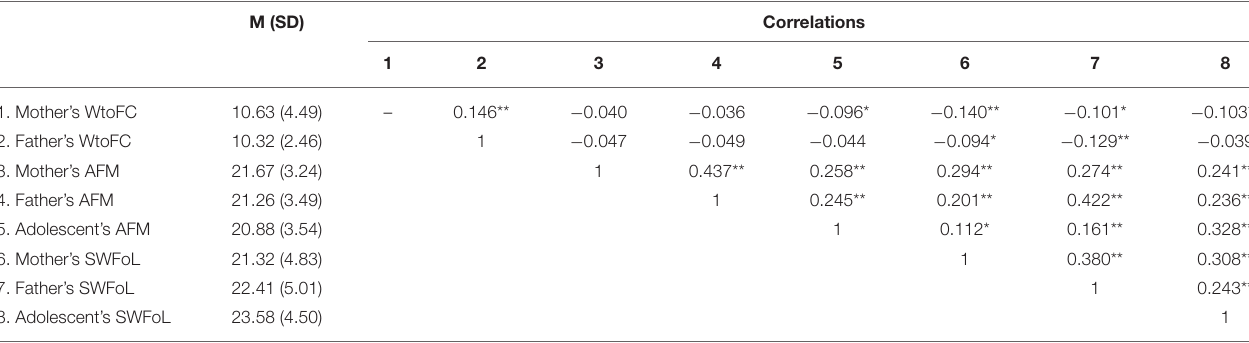
TABLE 2 | Descriptive statistics and correlations for parent’s Work-to-Family Conflict (WtoFC) and the three family members’ Atmosphere of Family Meals (AFM), and Satisfaction with Food-related Life (SWFoL) in dual-earner parents with adolescent children ( n = 473). M